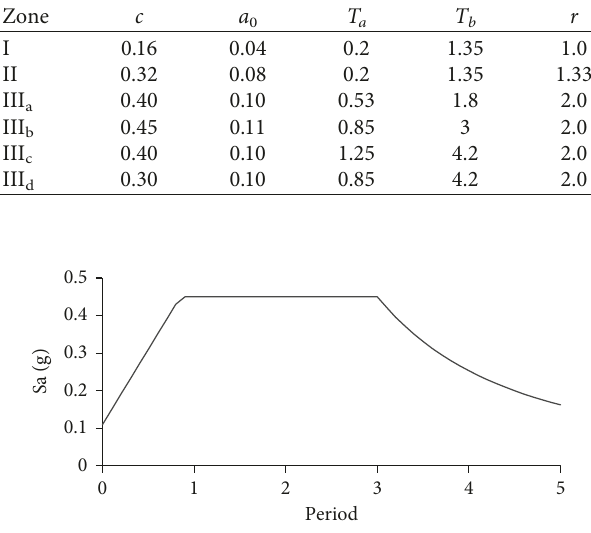
Figure 2: Design spectrum of Mexico City zone III b with a base of 20 cm. Corrugated bar numbers 3 to 8 are used with the same distribution in the lower and upper parts. Bars number 2 and 3 are used as stirrups with different sepa- rations. A total 2048 sections are considered. Columns . Square columns were used varying in cross sec- tions from 20 cm to 95 cm. Corrugated bar numbers 3 to 10 are used for reinforcement, and the longitudinal re- inforcement area vary from 1% to 4% of the transversal section. Bar number 3 are used as stirrups with different separations. A total 2048 sections are used. Slabs . Heights from 10 cm to 25 cm were proposed with different reinforcements in the upper and lower parts. Corrugated bars number 3 and 4 are used. A total 1024 sections are considered.